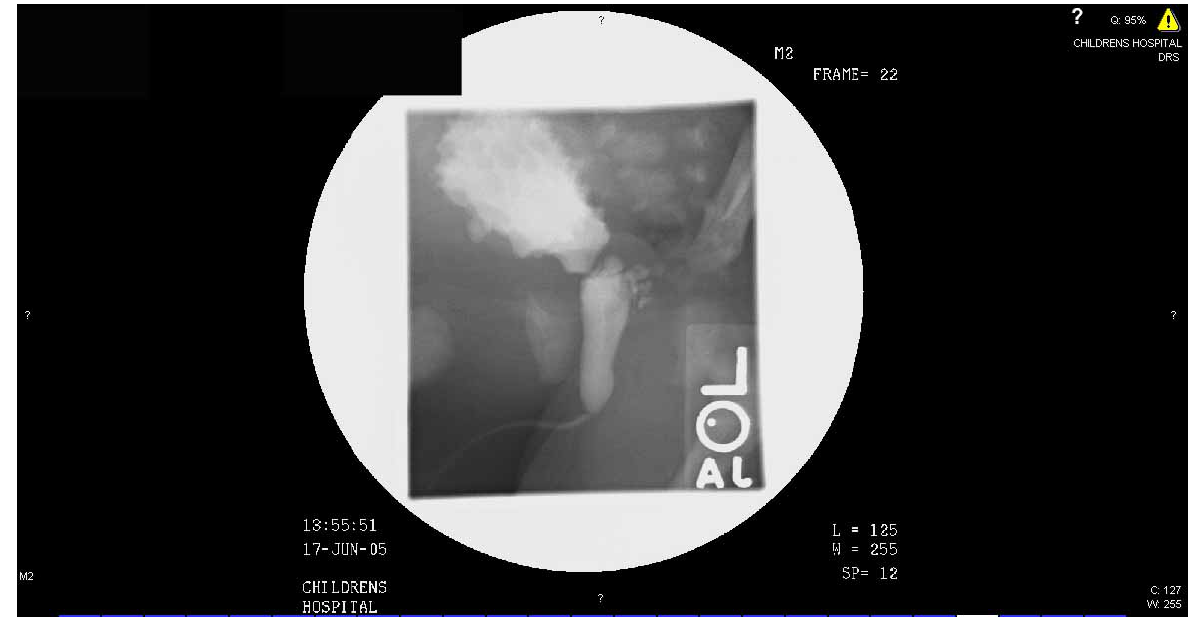
FIGURE 6D. VCU demonstrating a dilated prostatic urethra and a trabeculated bladder secondary to posterior urethral